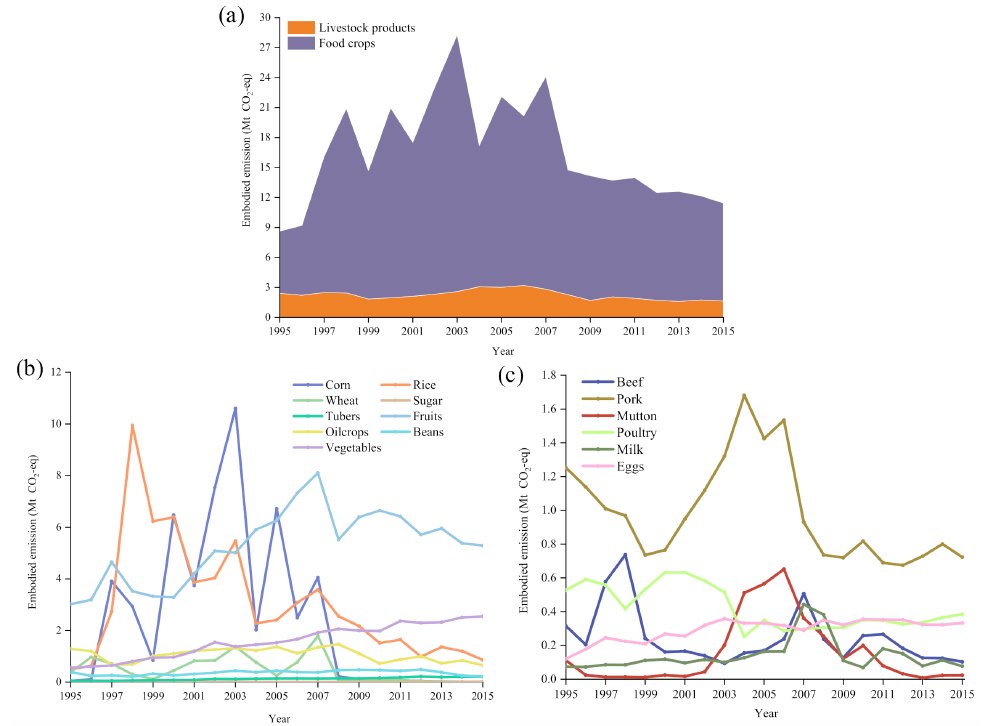
Figure 2. GHG emissions embodied in China’s export of agricultural products: ( a ) total agricultural products during 1995–2015; ( b ) food crops during 1995–2015; ( c ) livestock products during